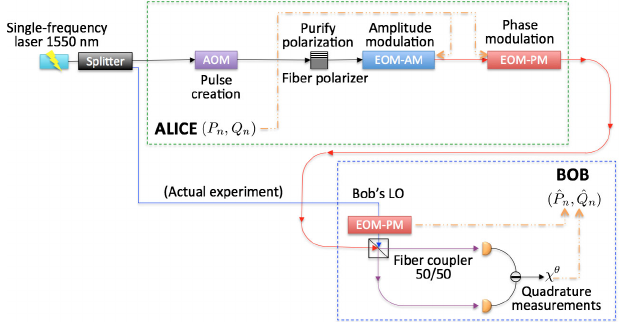
FIG. 4. Schematic of experimental setup for a proof-of-principle demonstration of SR-CV-QKD. The only difference between this schematic and Fig. 1 is the use of a shared laser source between Alice and Bob for experimental